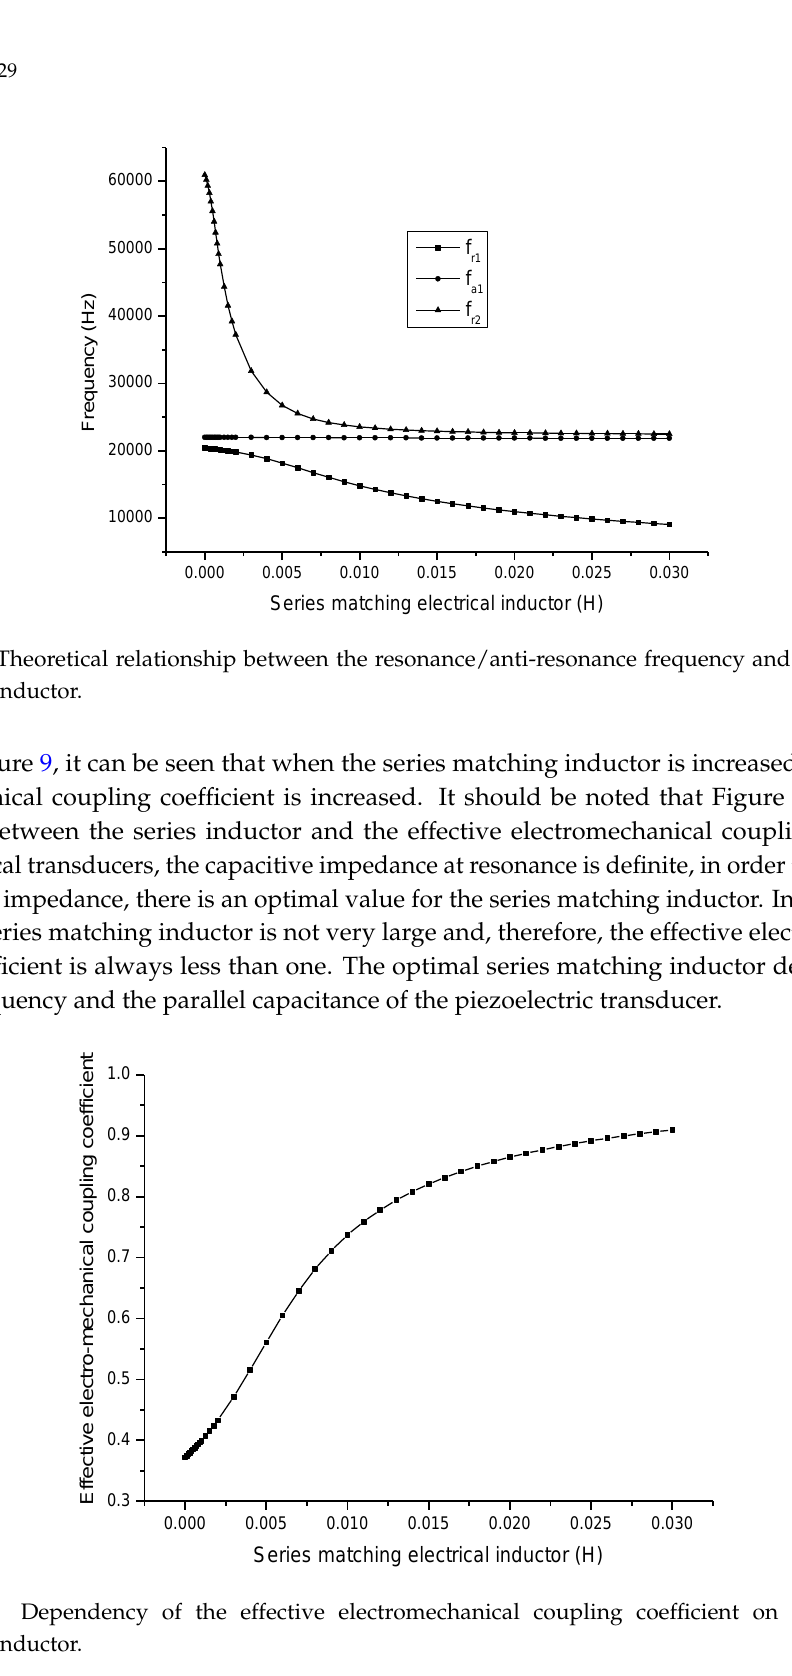
Figure 10. Theoretical relationship between the electric quality factor and the series matching inductor. -0.002 0.000 0.002 0.004 0.006 0.008 0.010 0.012 0.0140.0 0.20.40.60.8 1.0 E l e c t r oa c ou s t i c a l e ff i c i en cy Series matching electrical inductor (H)  r1  a1  r2 Figure 11. Dependency of the electro-acoustic efficiency on the series matching inductor.